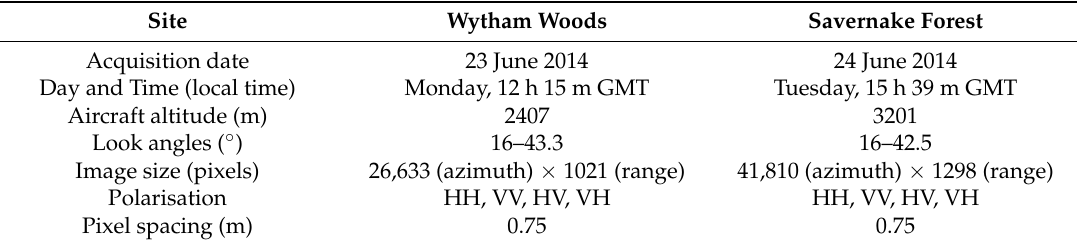
Table 4. Summary of the AirSAR data used in this